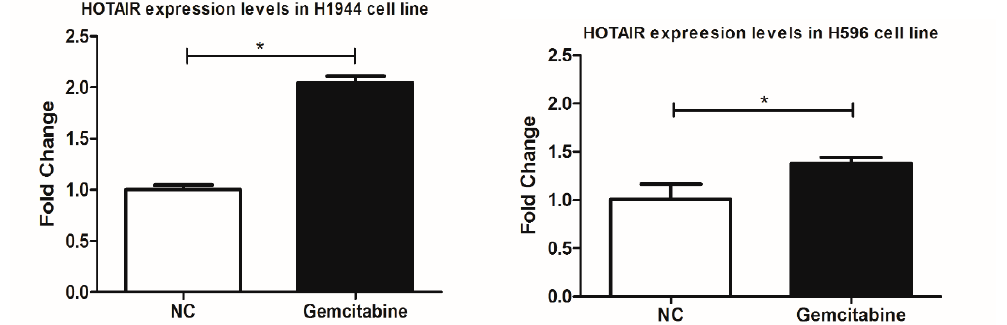
Figure 2. Analysis of HOTAIR gene expression in Gemcitabine treated H1944 and H596 cell lines by qRT-PCR (NC: negative control, *: p <